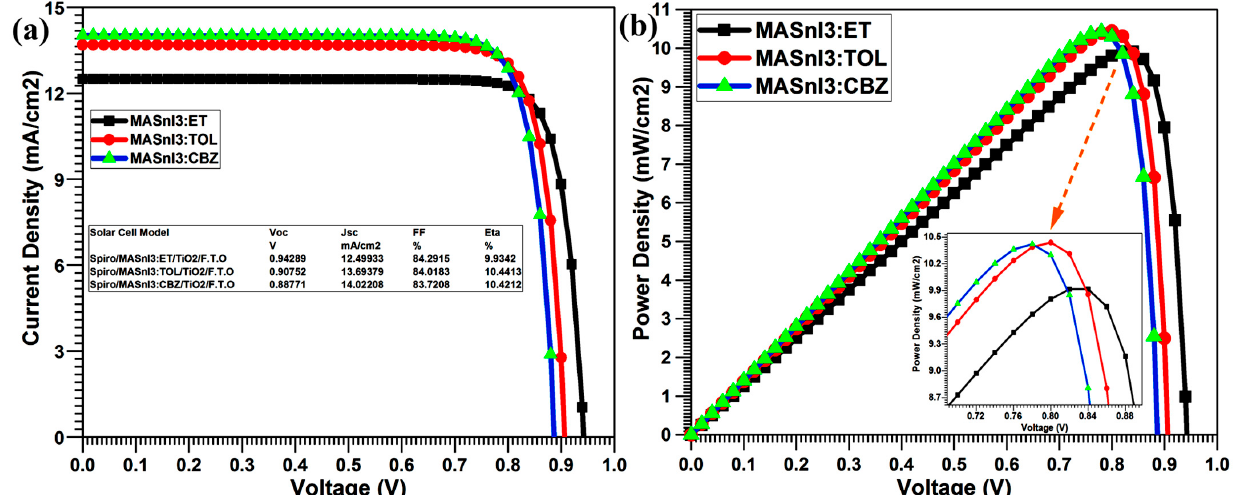
Figure 6. ( a ) J–V and ( b ) P–V characteristics curves of MASnI 3 -based solar cell. Diethyl ether antisolvent-based MASnI 3 produced V oc of 0.94 V, J sc of 12.49 mA/cm 2 , FF of 84.29%, and Eta of 9.93% during the simulation of solar cells. We notice that diethyl ether is less effective because, chlorobenzene V oc , J sc , FF, and Eta were registered as 0.88 V, 14.02 mA/cm 2 , 83.72%, and 10.42%, respectively, which was good in comparison to when ET was used as antisolvent as shown in Table 4. Table 4. Experimental Characteristics Parameters MASnI 3 -based solar cell.